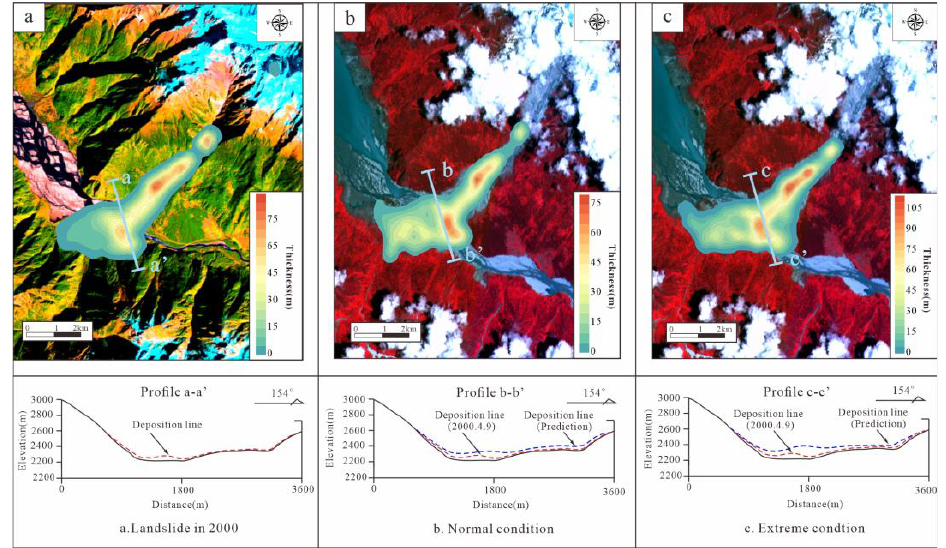
Figure 11. Simulation profile of the deposits dam under different simulation conditions. ( a ) the simulation contour map and deposits dam profile of Yigong landslide in 2000; ( b ) the simulation contour map and deposits dam profile of normal condition; ( c ) the simulation contour map and deposits dam profile of extreme condition.